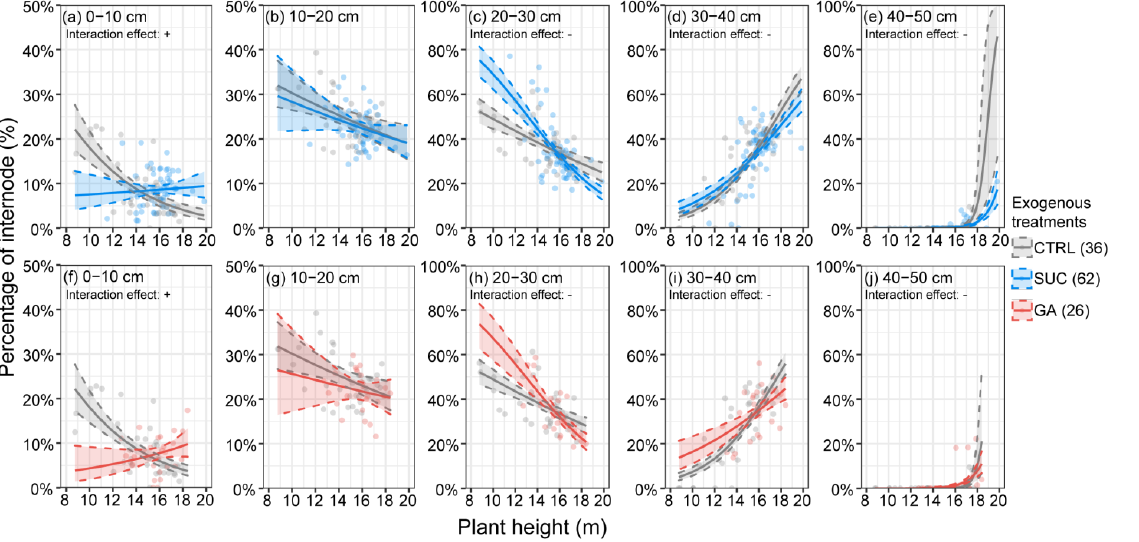
Figure 7. Comparison of the estimated biomass and carbon storage under different exogenous treat- ments. The numbers at the bottom of the bar graph represent the average values. The error bars show the 95% Bayesian credible intervals. The asterisk means a significant difference according to the Bayesian GLMM. The numbers in brackets represent the sample sizes.